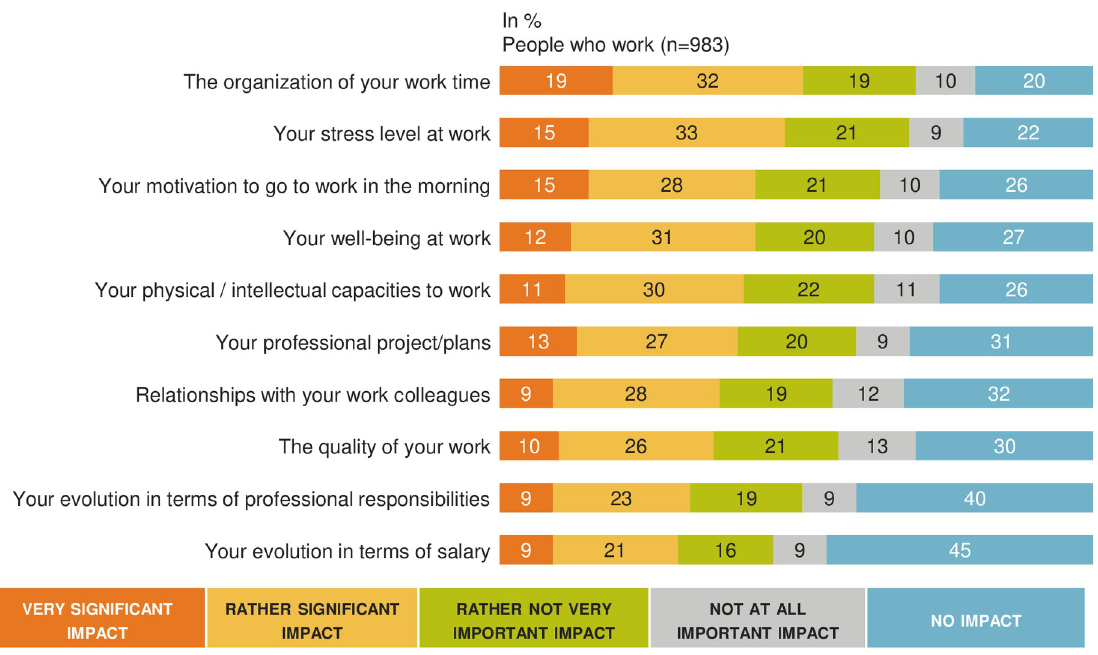
PLOS ONE | https://doi.org/10.1371/journal.pone.0238945 September 24,